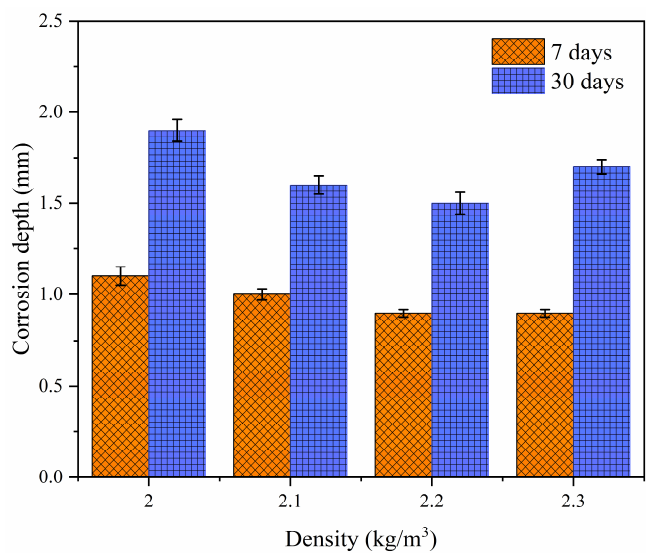
Figure 11. Corrosion depth of high-density anti-corrosion cement slurry.